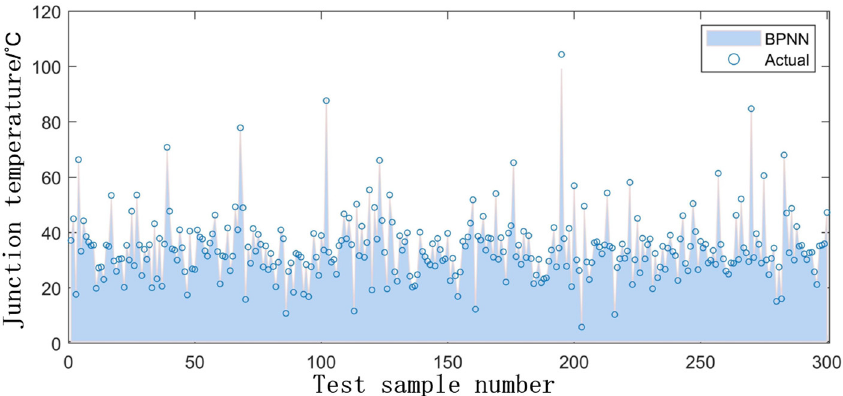
Figure 11. Predicted junction temperature of the ELM model.